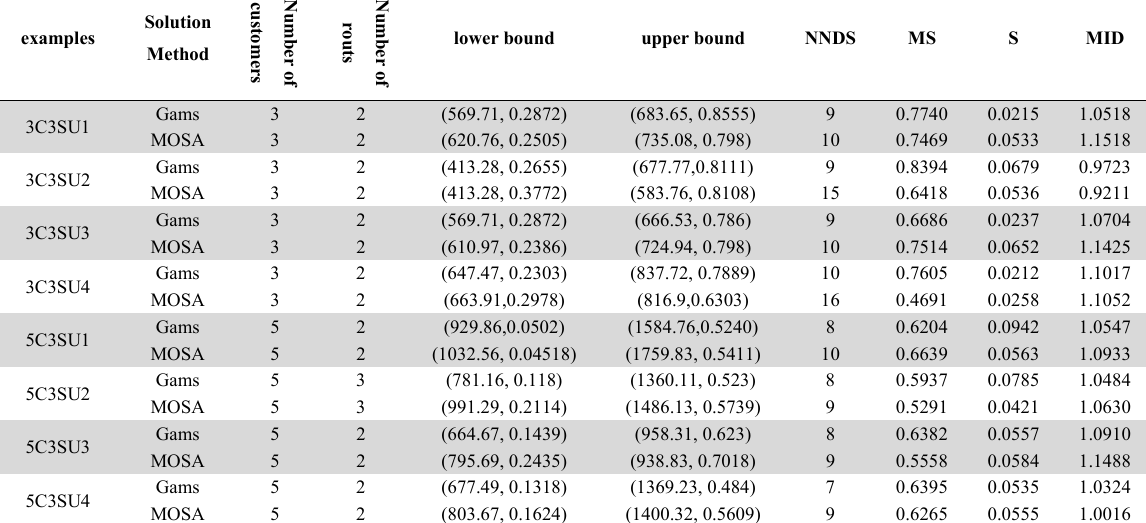
Results and metrics values of GAMS and MOSA algorithm